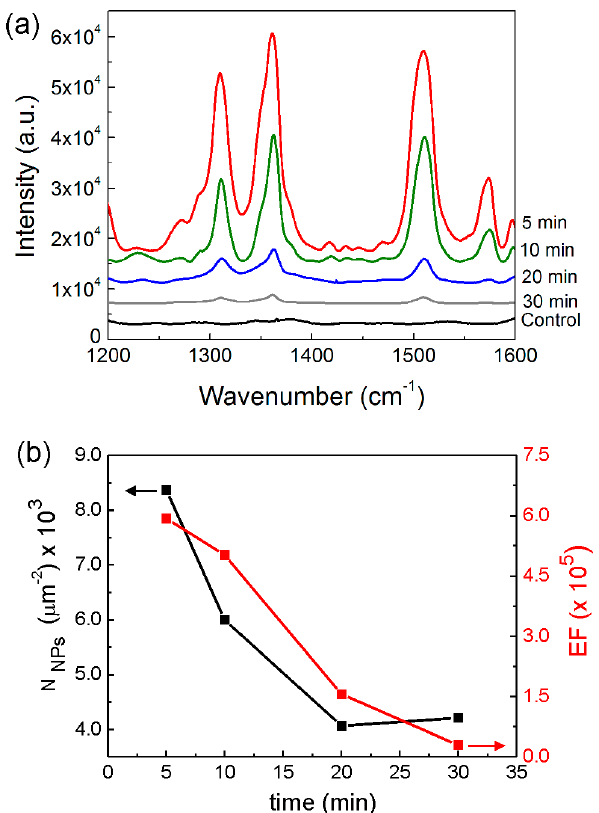
Figure 8. ( a ) Raman spectra of 10 − 6 M of rhodamine 6 G (R6G) on ZnO nanorods (NRs) with and without (control) Ag nanoparticles (NPs). The NRs were produced at 70 °C with different synthesis times (5, 10, 20 and 30 min). ( b ) Enhancement factor (EF) and estimated number of Ag NPs (N NPS ) per square micrometre, as a function of the ZnO NR synthesis times.